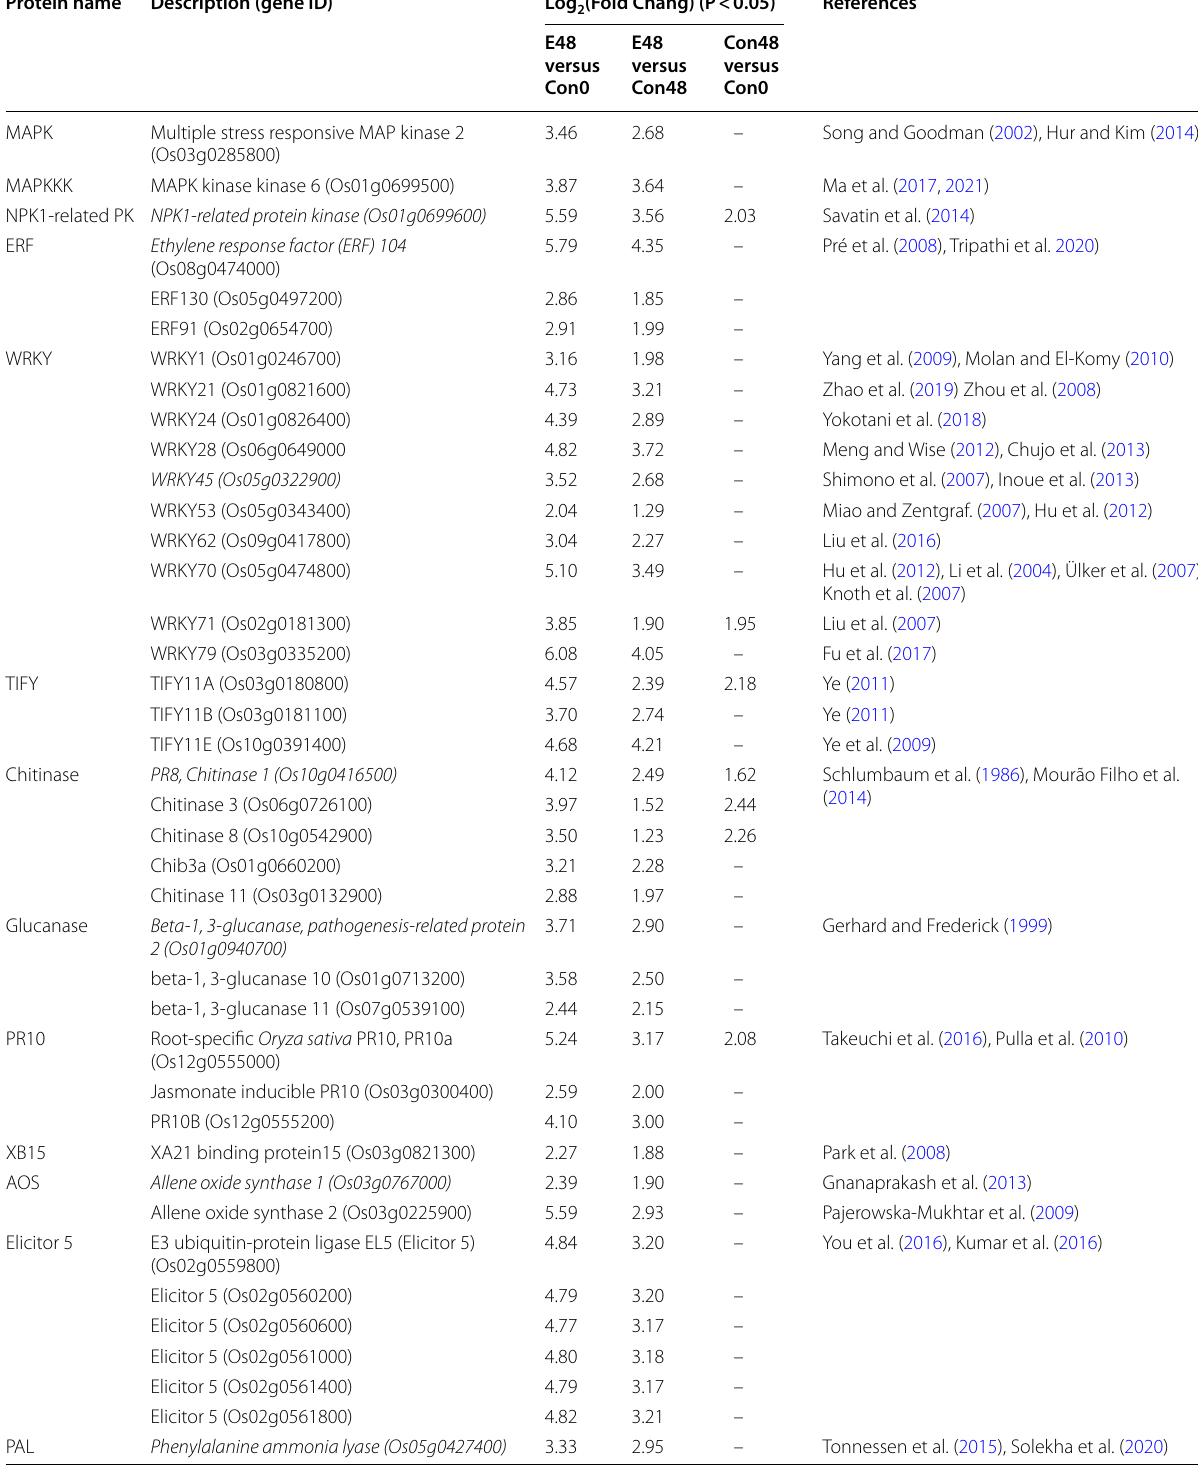
Table 1 Information regarding disease resistance-related genes with EsxA-induced up-regulated transcription levels Protein